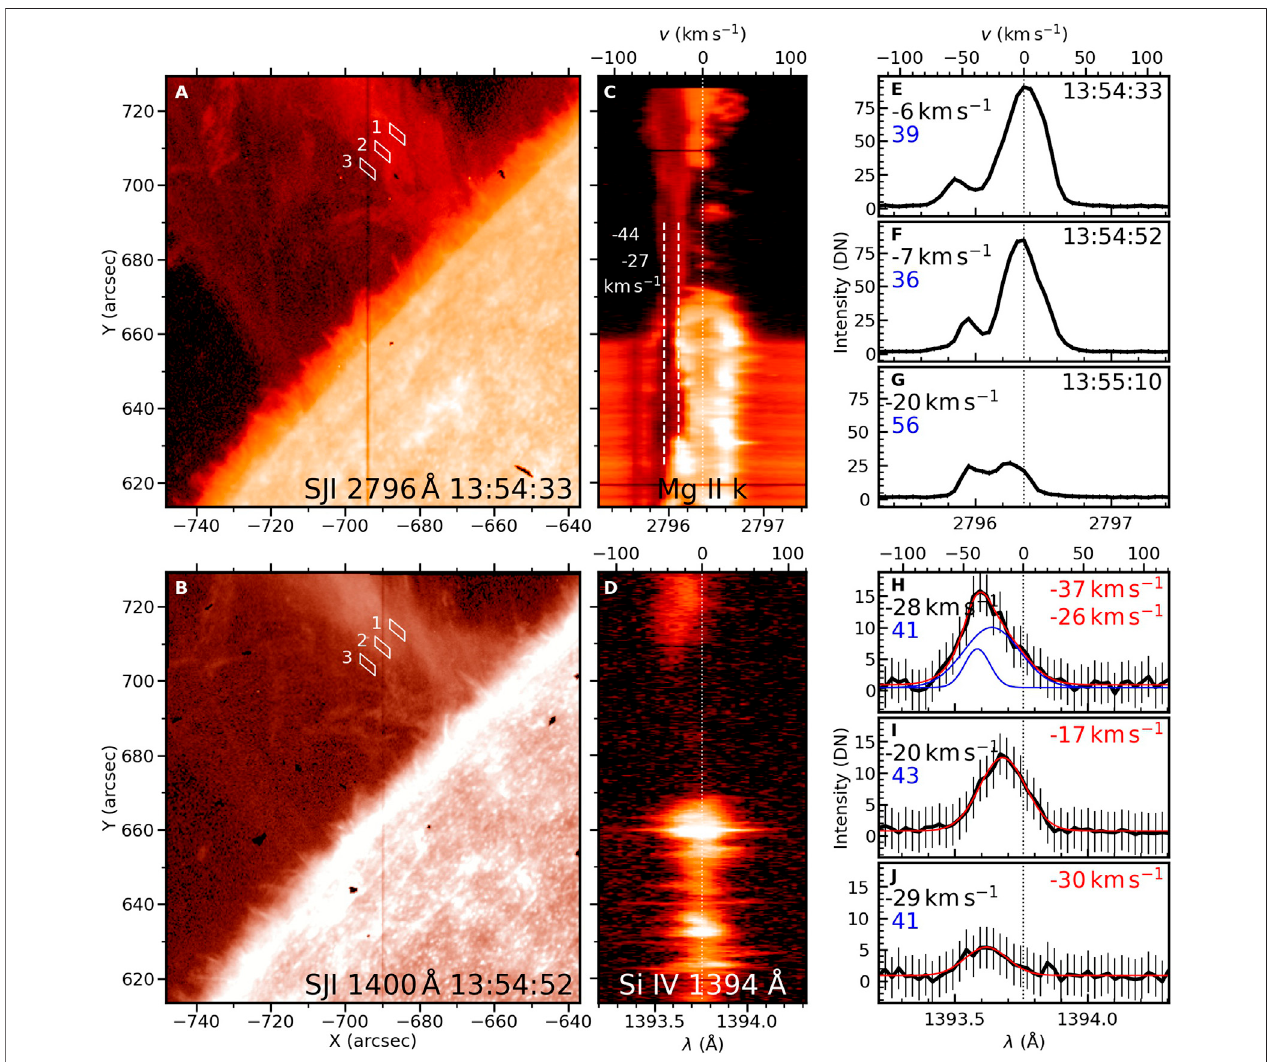
FIGURE 5 | Spectral observations around 13:54 UT, similar to Figures 3 , 4